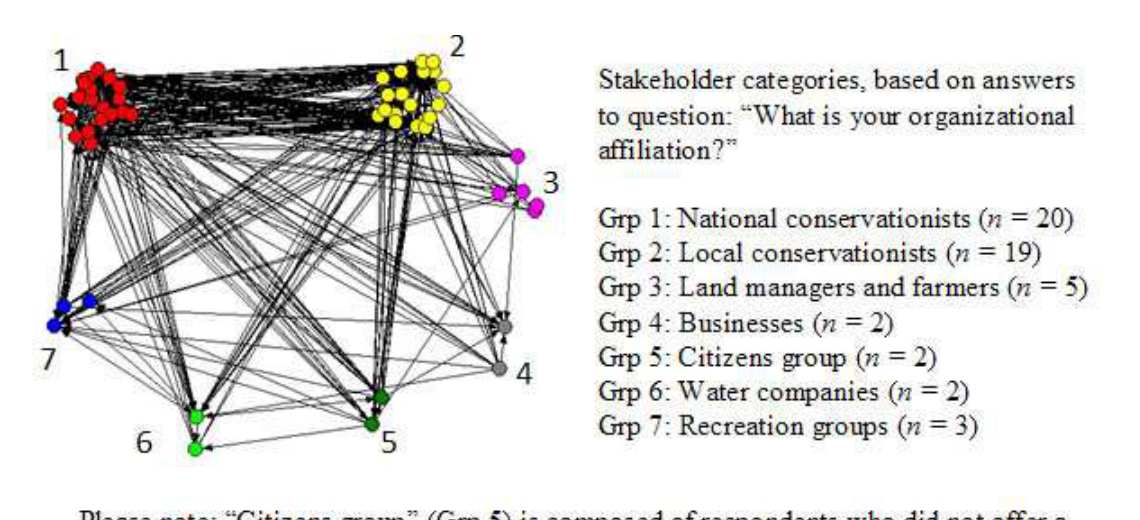
Fig. 1. Digraph showing stakeholder communication network ( n =